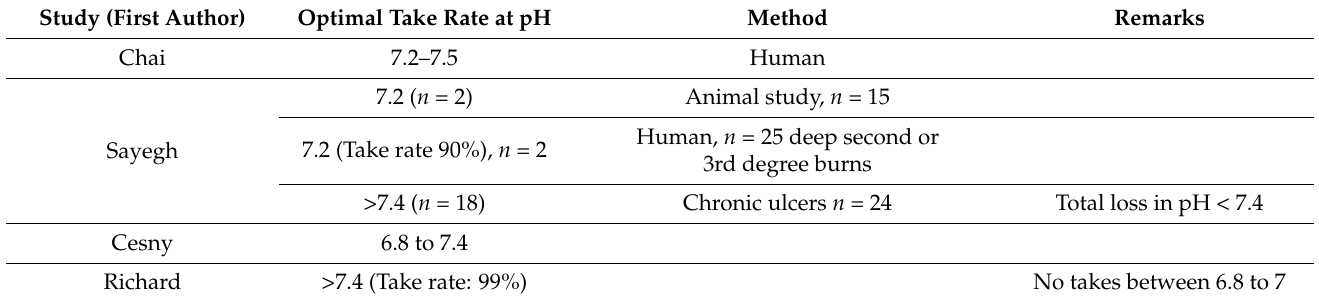
Table 2. Optimum wound pH for grafting from